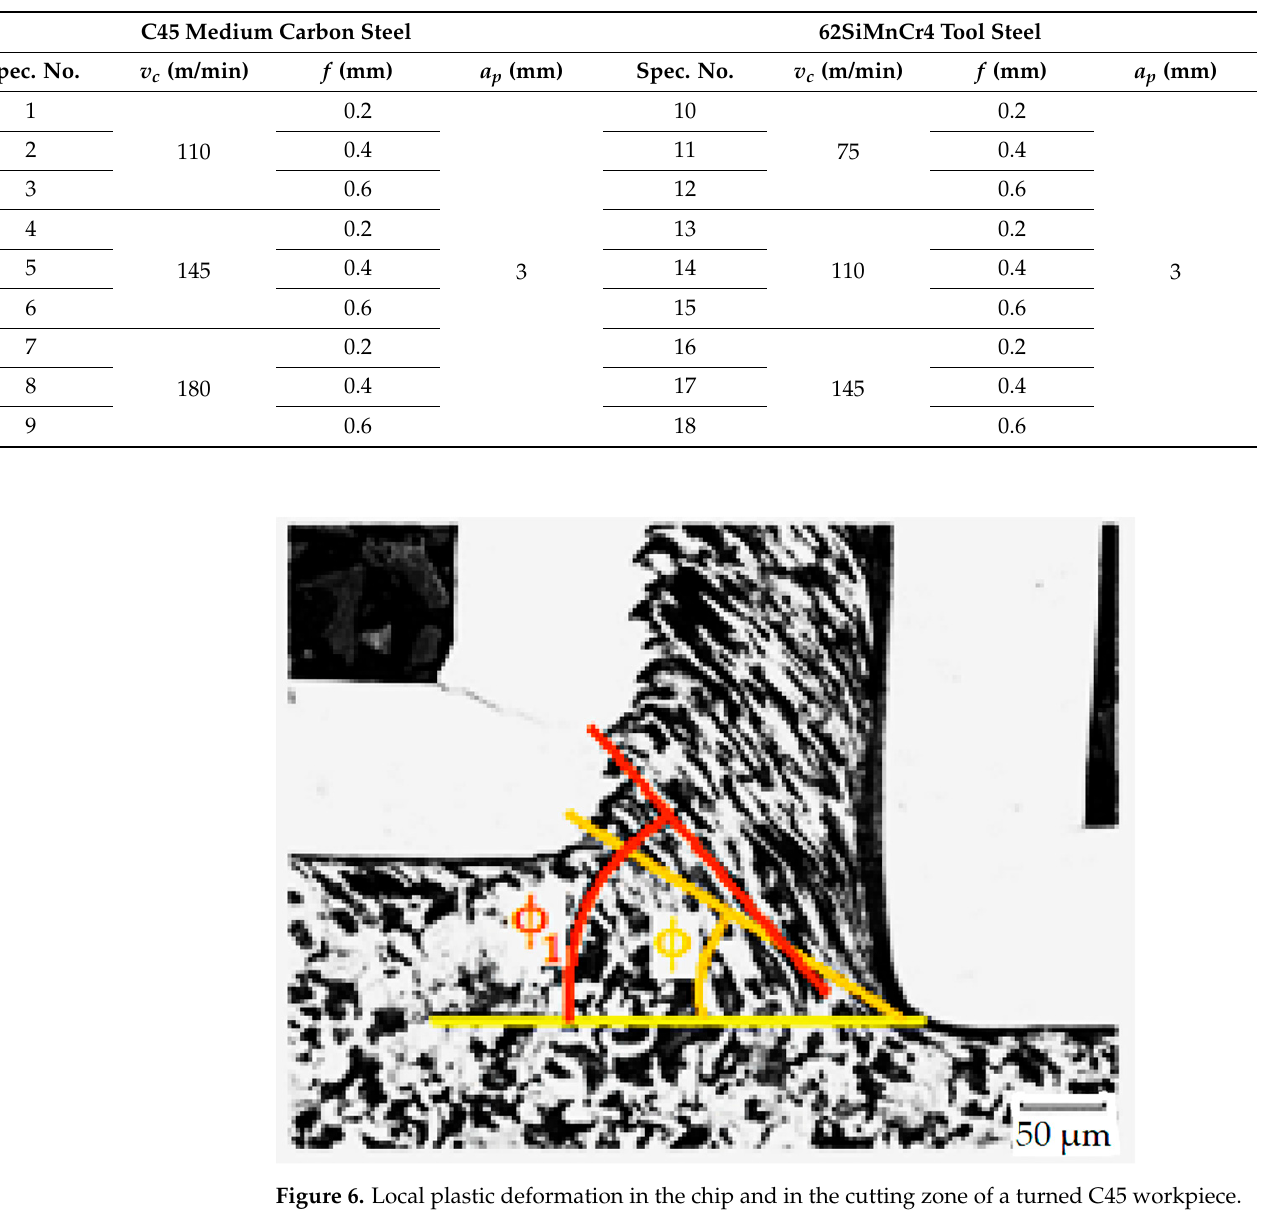
Figure 7. The result was proportional to the grain boundaries’ deformation degree, and the local plastic deformation was estimated by Equation (1) [56]. 𝜑 = 𝑙𝑛 (cid:4678)1 + 𝑂√2 (cid:3398) 𝑂 (cid:2870) 1 (cid:3398) 𝑂 (cid:2870)